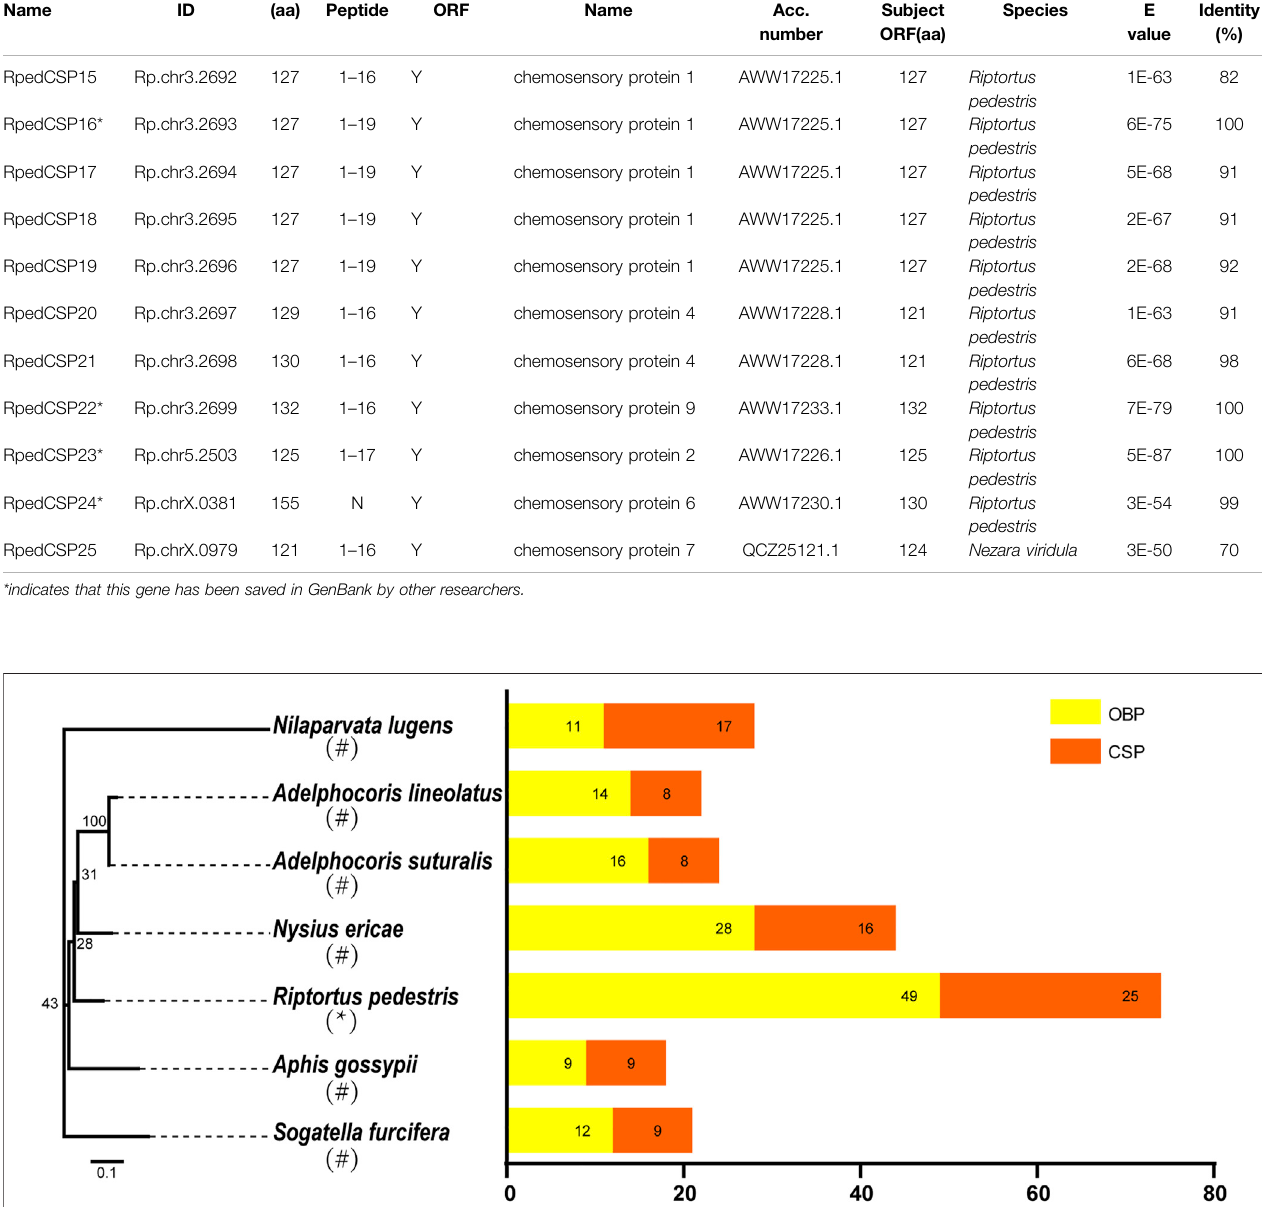
Table S1 ) were designed using Beacon Designer 7.9 (PREMIER